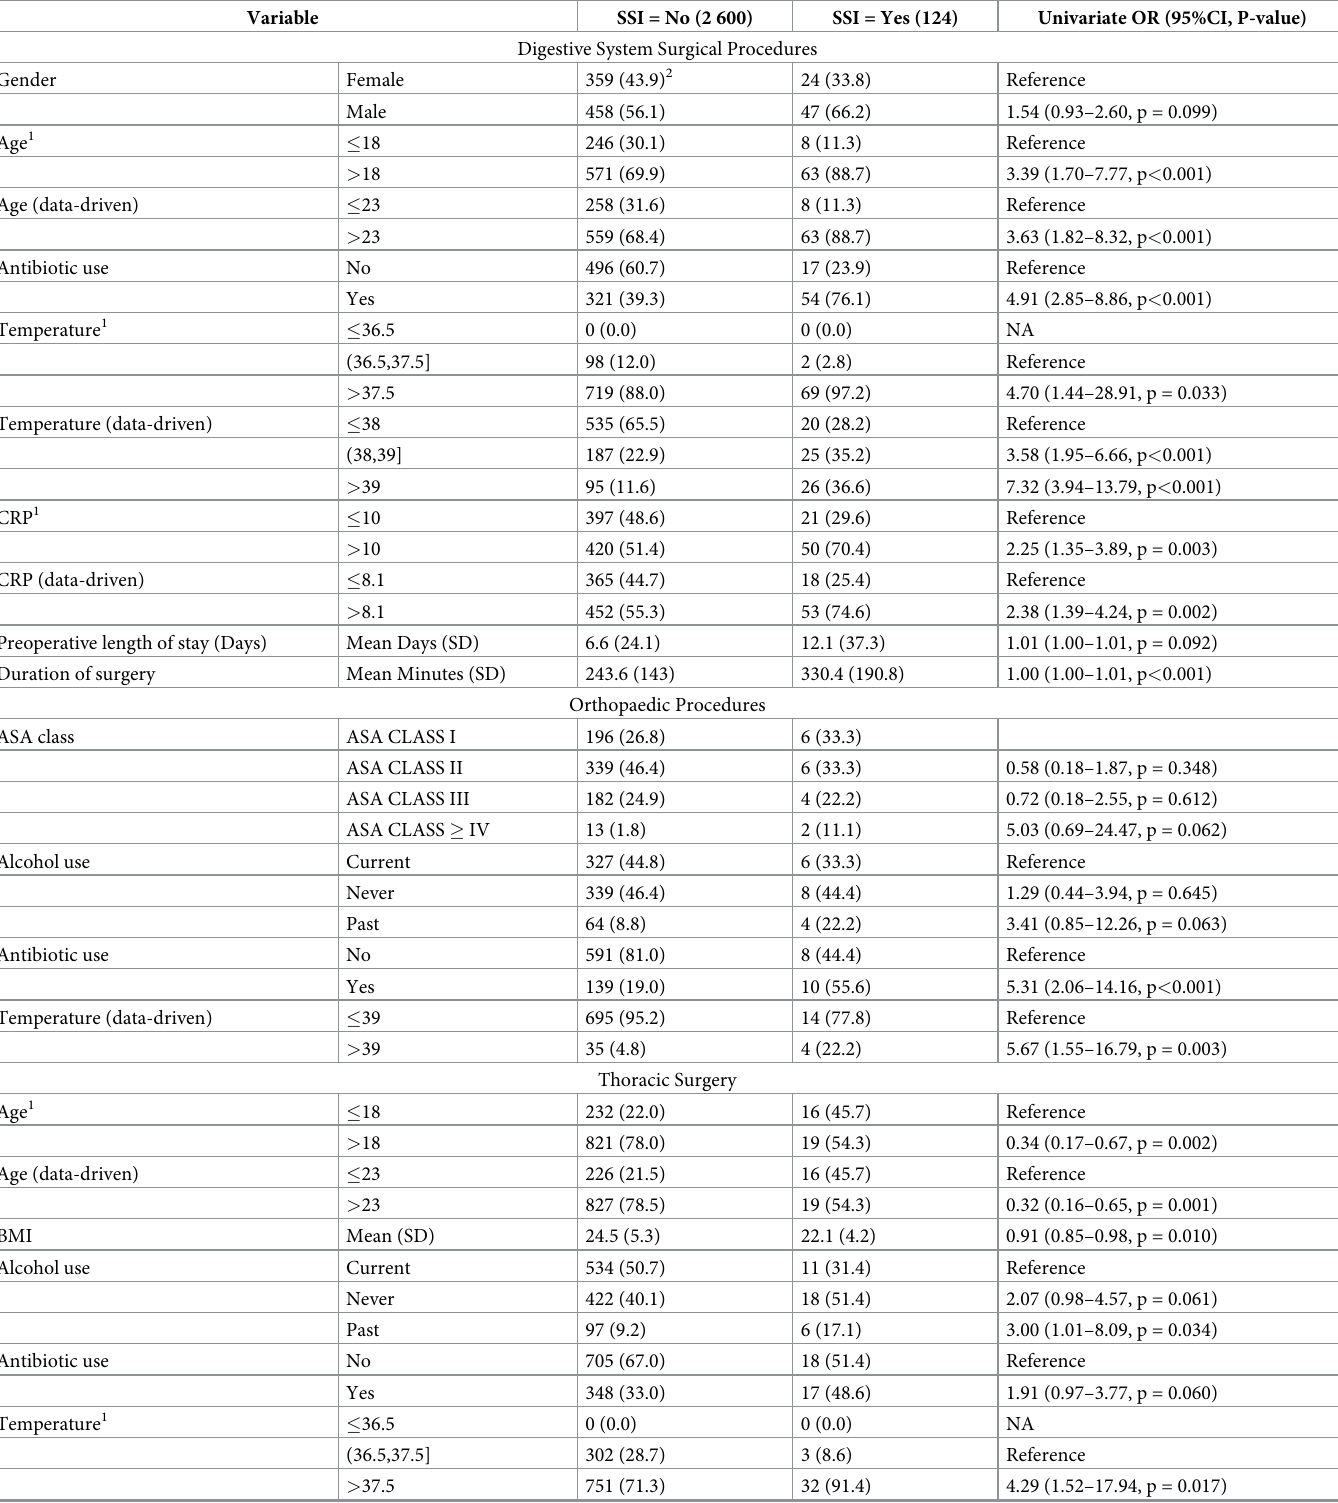
Table 2. Digestive system surgical procedures: univariate analysis of risk factors for the future occurrence of